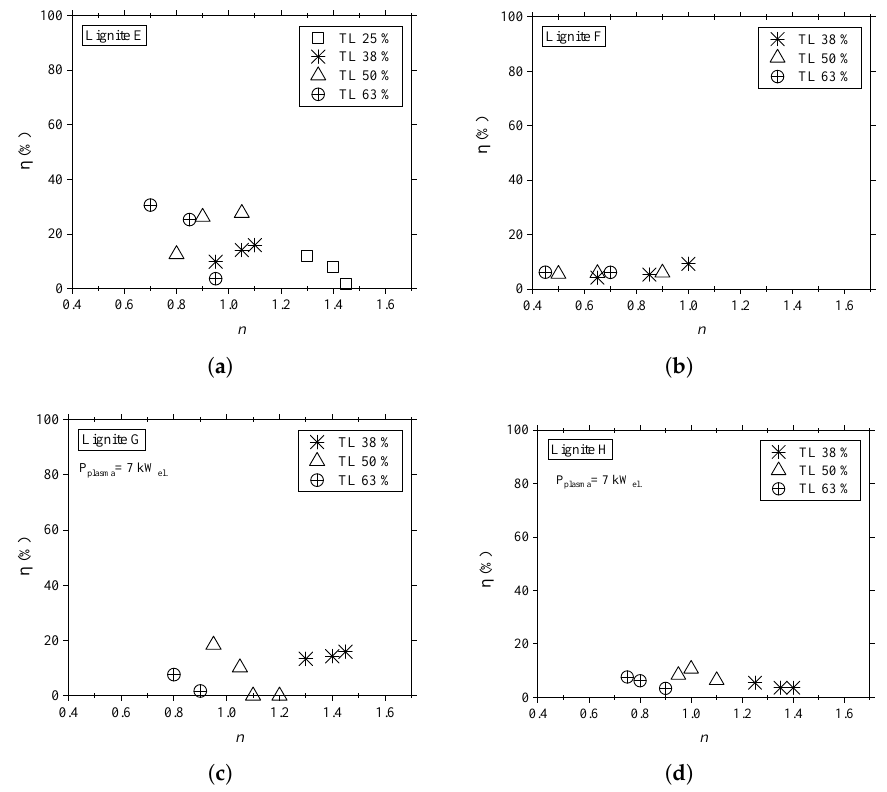
Figure 6. The Combustion Degree vs. air ratio at several thermal loads (TL) by ( a ) Lignite E, ( b ) Lignite F, ( c ) Lignite G, ( d ) Lignite